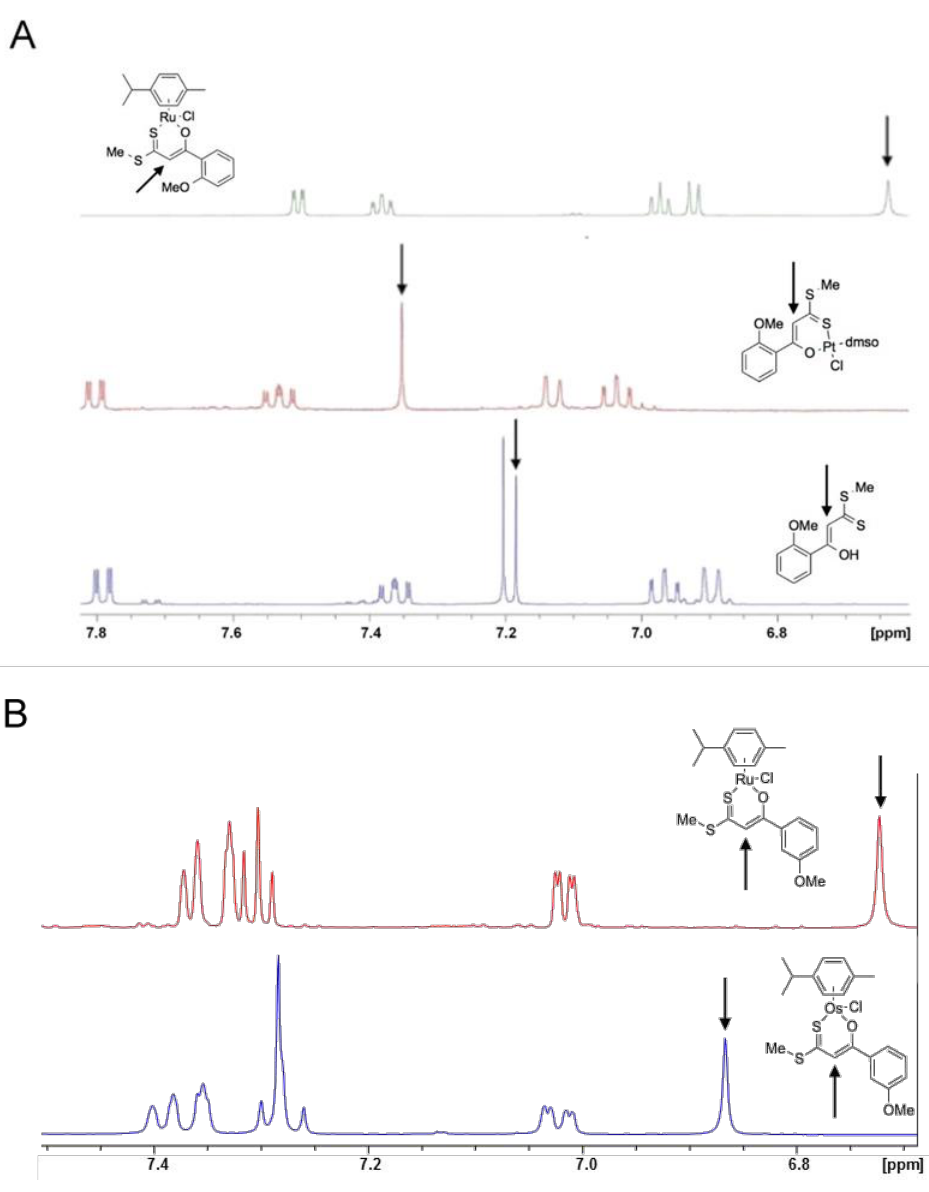
Figure 2. ( A ) Part of the 1H NMR spectra for L9/Ru9 and their corresponding Pt(II) complex, a significant shift of the marked methine proton is observable after complexation to the metals. ( B ) Shift of the methine proton for the Ru(II) and the Os(II) compounds 7; the Os(II) complexes do not shift as much (in comparison to the free ligand) as the Ru(II) analogues. Arrows depict the specific methin proton peak in the spectrum and the responsible position in the ligand.